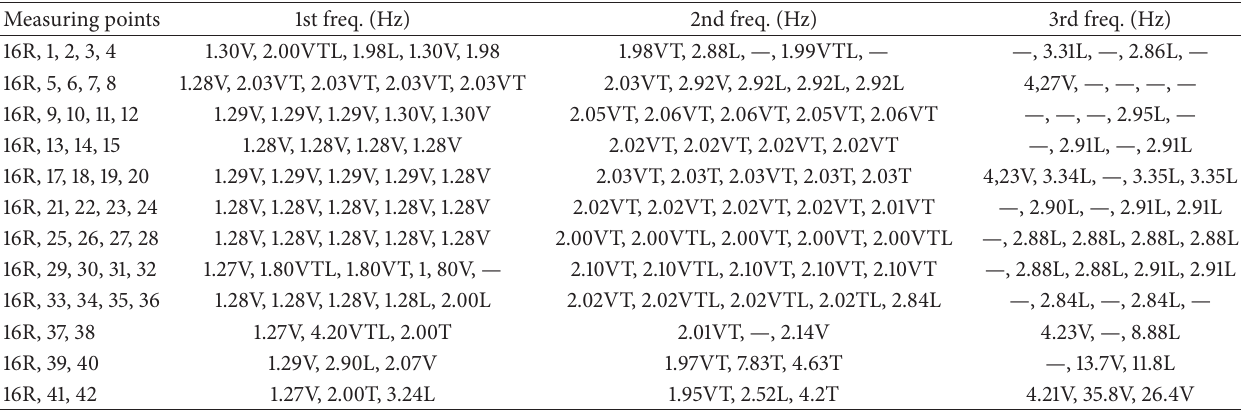
Table 6: Measured dominant frequency of upstream